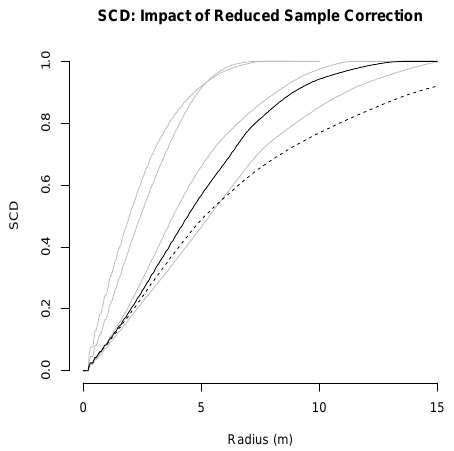
Figure 9: The SCD estimate for one location using re- duced sample correction (solid line) and no border cor- rection (dashed line). For context the reduced sample estimates of some other observations are shown in